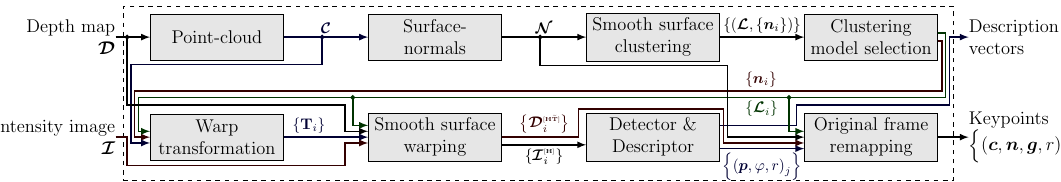
Figure 1. An overview of the proposed 3D-affine embedding pipeline. First, a point-cloud, , C and the surface normals, , are computed from the input depth map, (Section 2.1). Then, N D the surface normals are used to form several spherical k -mean modules in parallel, and the best ) , is selected to annotate the smooth surfaces in the scene (Section 2.2). After that, n i model, ( , L { } ( c , n ) all smooth surfaces are parameterized by their point-cloud and surface-normal centroids, , i } { T i and their individual warp transforms, , are computed (Section 2.3). Using their corresponding { } warp transforms, the smooth surfaces are rigidly warped and homographically morphed in parallel ( ) [ H ] [ H T ] into a viewpoint invariant representation, , (Section 2.4). Using the embedded i i I D { } (cid:101) detector/descriptor, keypoints are detected and then described in parallel from the intensity